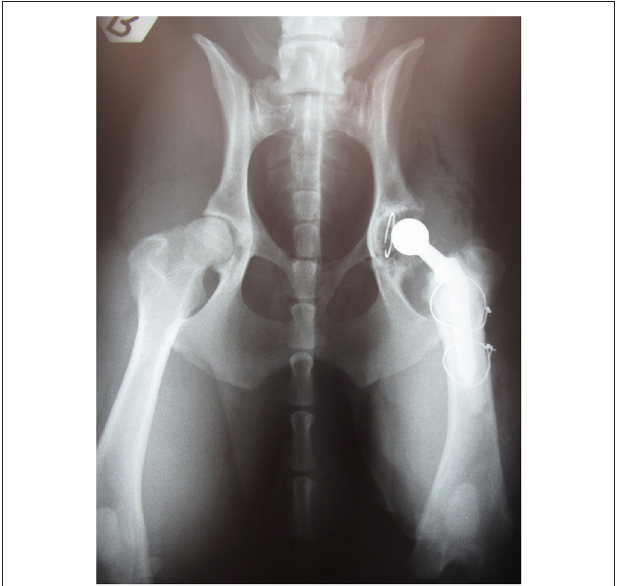
FIGURE 3 | Ventrodorsal radiographs after reimplantation. Proper positioning and orientation of the stem and proper mantle cement are visible. Two cerclage wires were used to stabilize the bone window